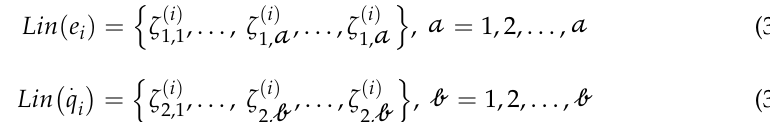
Figure 2. Membership function of fuzzy input of the 𝑖 (cid:3047)(cid:3035) subsystem.